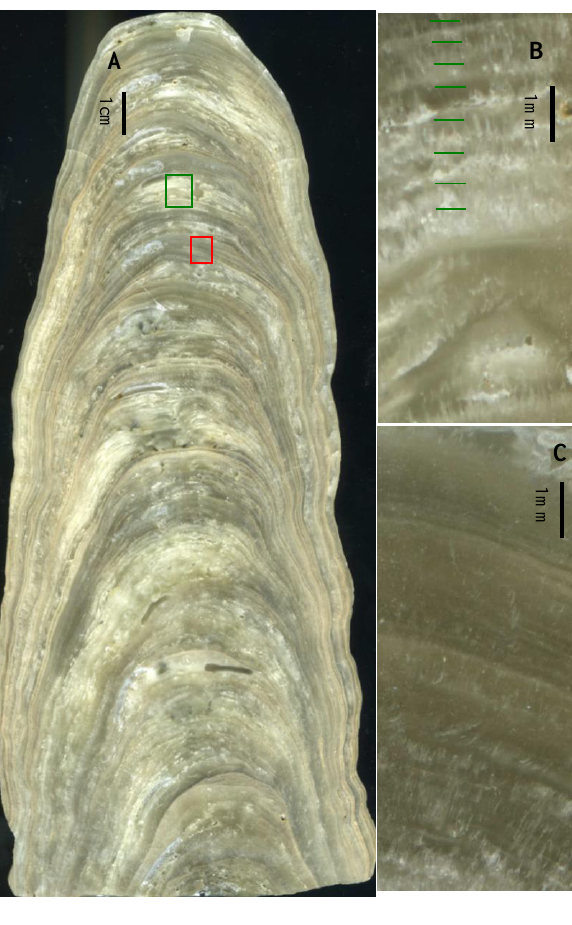
Fig. 2. (A) Polished surface of sample BD, showing lamina- tion alternations of white-porous and dark-compact calcite. (B) A higher-magnification view of the area in the green rectangle in (A) , displaying annual layers in white-porous calcite. (C) A higher-magnification view of the area in the red rectangle in (A) , showing the examples of annual layers preserved in dark-compact